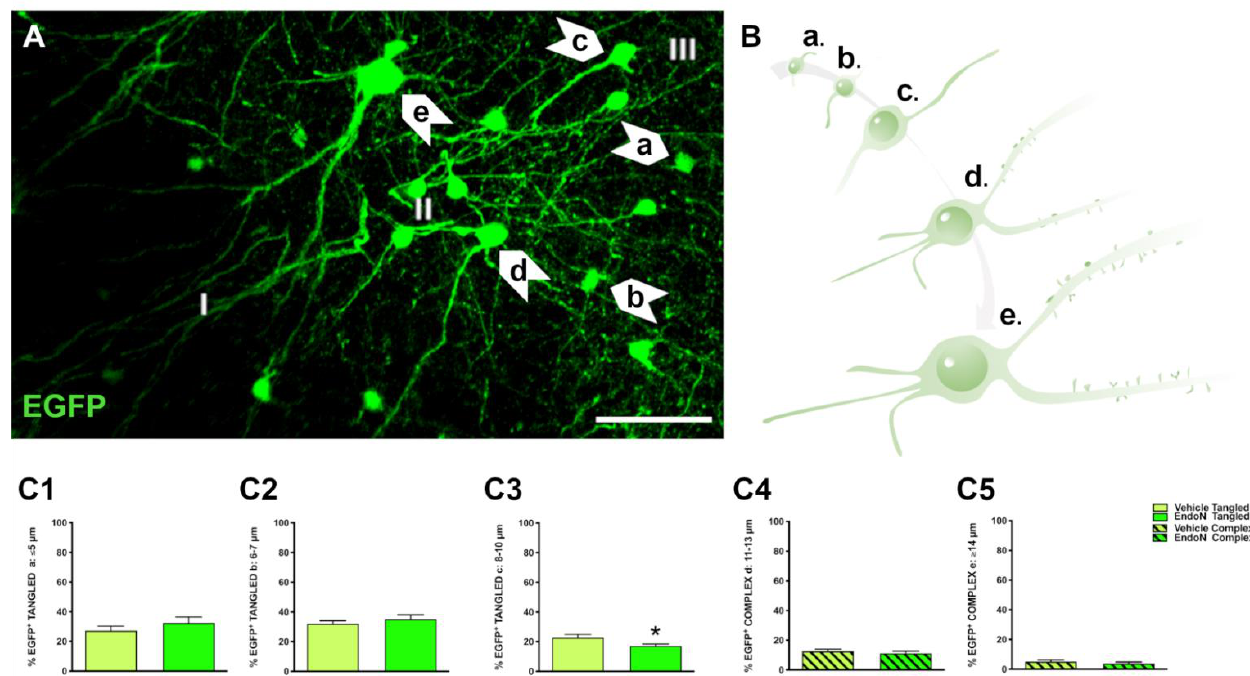
Figure 2. Classification of EGFP + neurons and impact of PSA depletion. ( A ) Single confocal section showing the distribution of EGFP + cells in the PCX layer II. Note the different subtypes of cells indicated by arrows. Scale bar = 50 µ m ( B ) Schematic representation showing the different maturational stages of EGFP + cells: a: ≤ 5 µ m; b: 6–7 µ m; c: 8–10 µ m; d: 11–13 µ m; e: ≥ 14 µ m ( C1 – 5 ) Graphs representing the percentage of the different types and maturational stages of EGFP + neurons in the PCX layer II. Asterisks indicate statistically significant differences between hemispheres (Vehicle vs. Endo-N) after paired Student’s t -test. (* p ≤ 0.05) Scale bar: 100 µm.